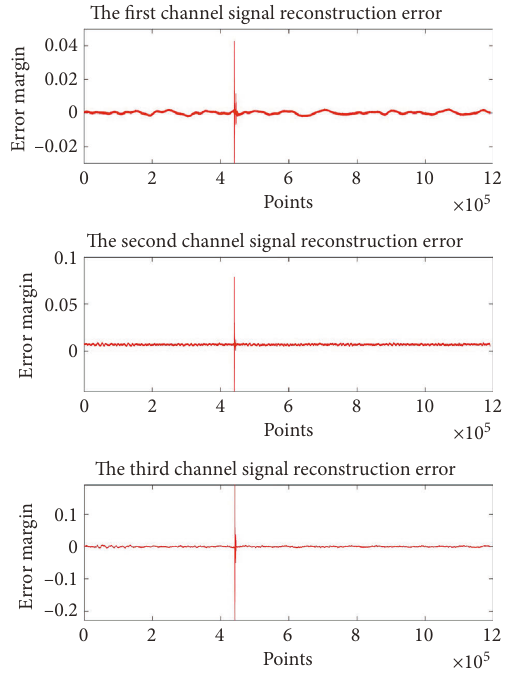
Figure 25: Three-way signal reconstruction